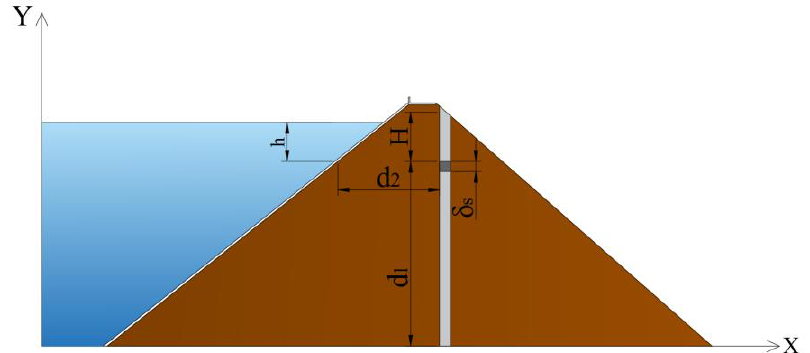
Figure 1. Schematic diagram of monitoring point affected by rheology and soil